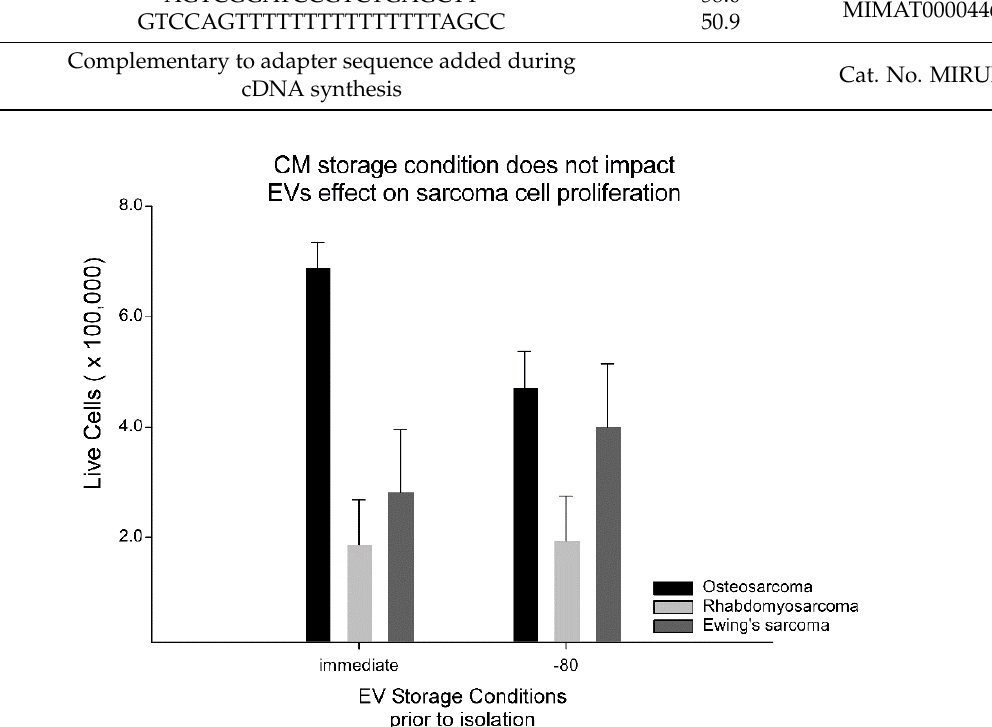
Figure 9. Storage condition prior to EV isolation had no effect on sarcoma cell proliferation. ANOVA main effects (STORAGE CONDTION or DOSE), and interactions terms (DOSE × STORAGE CONDITION) and (DOSE × STORAGE CONDITION × CANCER TYPE) indicated there was insufficient evidence to reject the null hypothesis. Data graphed here are the composite means from the ANOVA table (STORAGE CONDITION × CANCER TYPE and the associated standard error of the mean, SEM). Thus, there was no effect of EV dose (0, 5 × 10 5 , 1 × 10 6 , 1 × 10 7 , 1 × 10 8 EVs per well), sarcoma cell line tested (seven lines), or pre-processing storage condition on sarcoma cell proliferation. Note 4 different osteosarcoma cell lines, 1 Ewing’s sarcoma cell line, and 2 rhabdomyosarcoma cell lines were